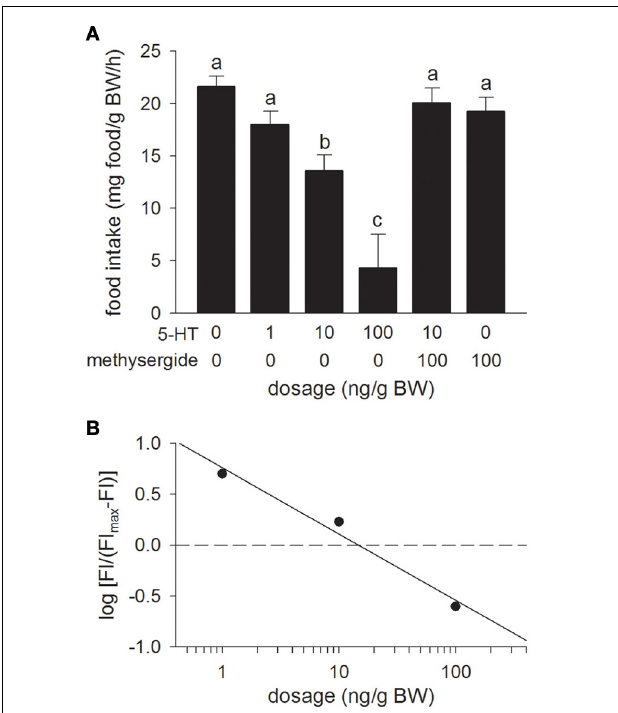
FIGURE 3 | (A) Effects of i.c.v. injections of modified teleost Ringer’s (30% methanol, 70% teleost Ringer’s) or serotonin (5-HT) alone, or in combination with the mixed 5-HT 1 /5-HT 2 receptor antagonist, methysergide on food intake in rainbow trout. Assessment of food intake was carried out as in Figure 1 . Bars that do not share a common letter are significantly different from each other as determined by a One-Way ANOVA and by a pairwise Tukey’s test ( P < 0 . 05). Values are means + sem ( n = 8). (B) Hill plot demonstrating the half-maximal effective dose (ED 50 ) of 5-HT (ED 50 = 14 . 7ng/g BW) i.c.v. injections on food intake (FI).